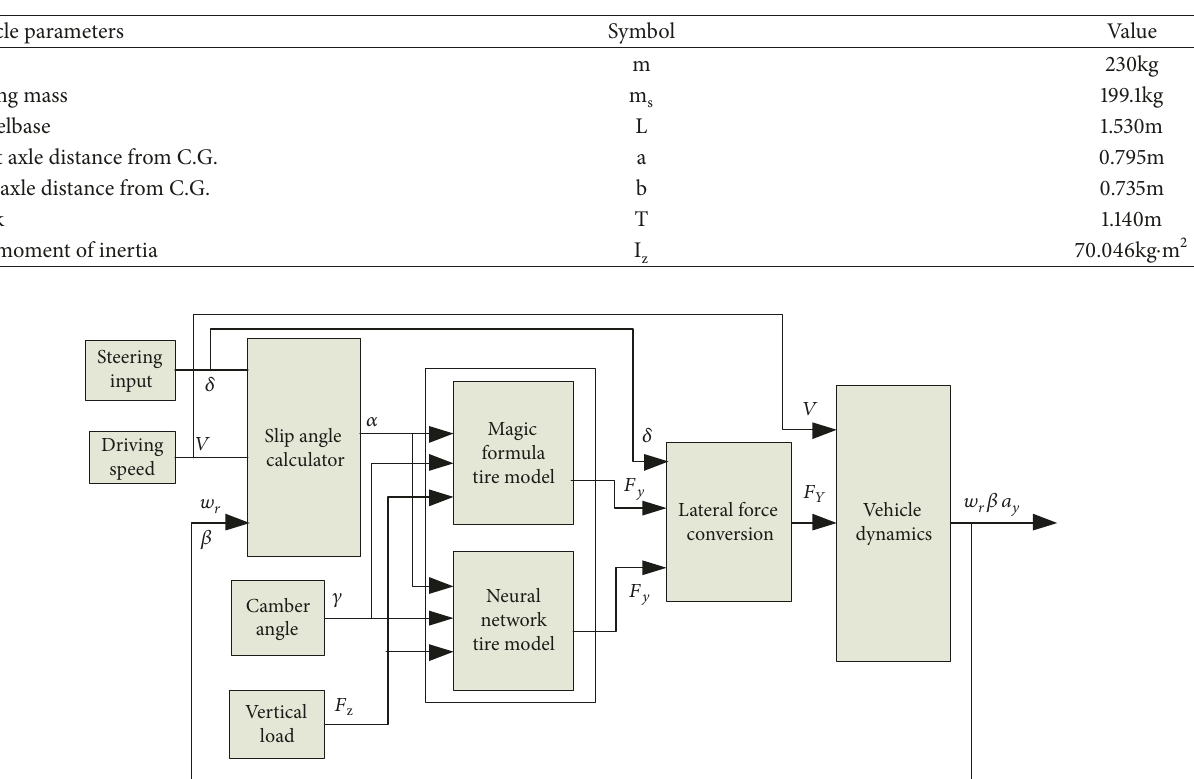
Figure 11: Simulation diagram of the nonlinear vehicle model with 2